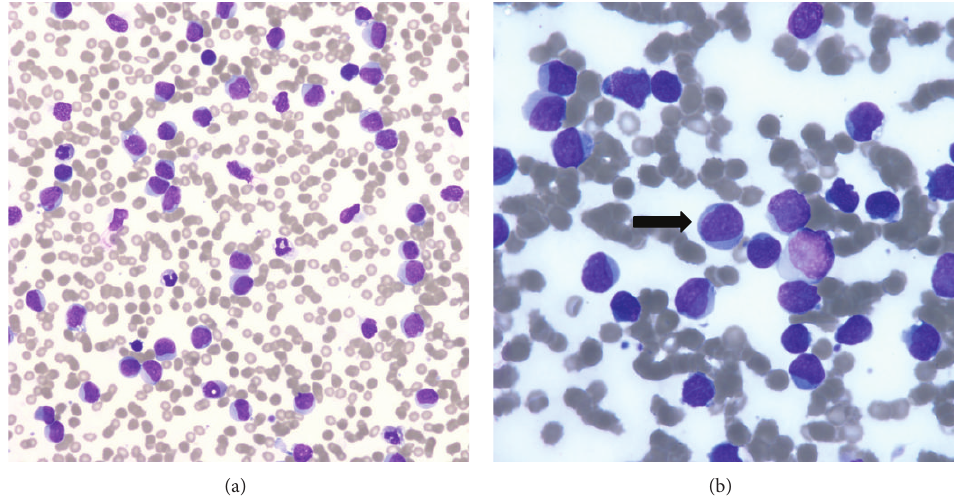
Figure 1: 200x (a) and 500x oil (b) poweredperipheral blood smear demonstrating numerous circulating blasts (81%) without Auer rods (black arrow) consistent with acute myeloid leukemia.